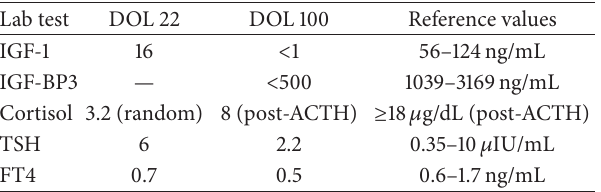
Table 1: Endocrinology workup obtained at day of life 22, compared with that obtained at day of life 100 (3 months of